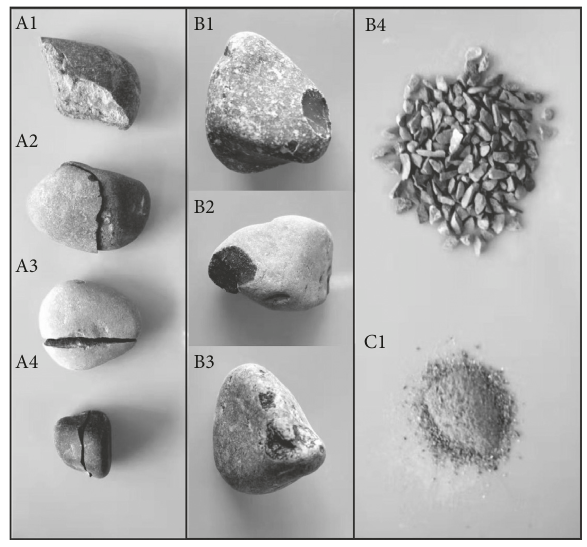
Figure 1: The morphology of particle breakage after testing.